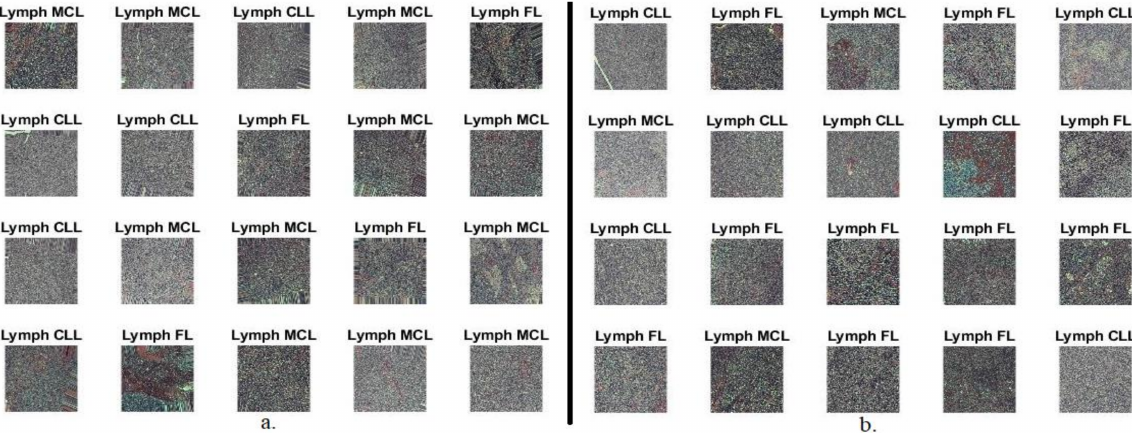
Figure 3. Some samples of histopathological images of malignant lymphomas after enhancement: ( a ) First dataset and ( b ) Second